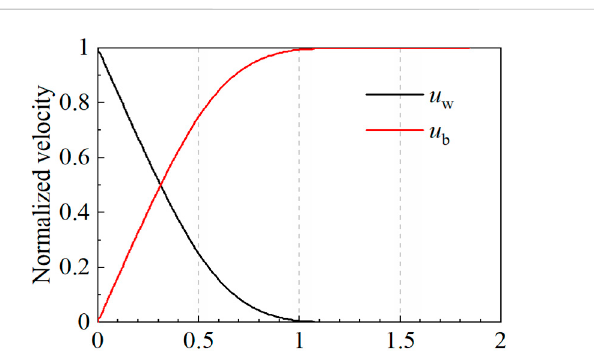
FIGURE 6 Blasius pro fi le representing speeds of a fl ow u b at the top of a fl at plane.